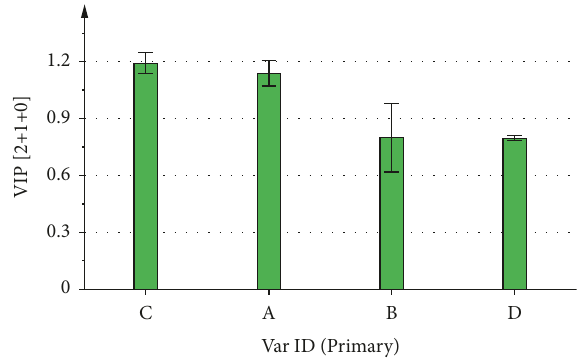
Figure 14: VIP of 4 variables in OPLS-DA model of Acacia catechu .